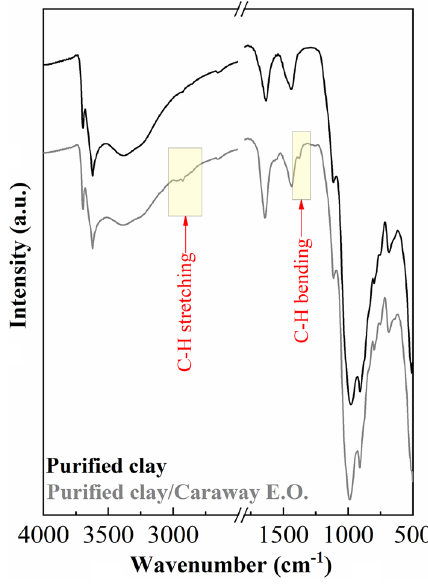
Figure 10. FT-IR spectra of purified clay and purified clay/CEO.